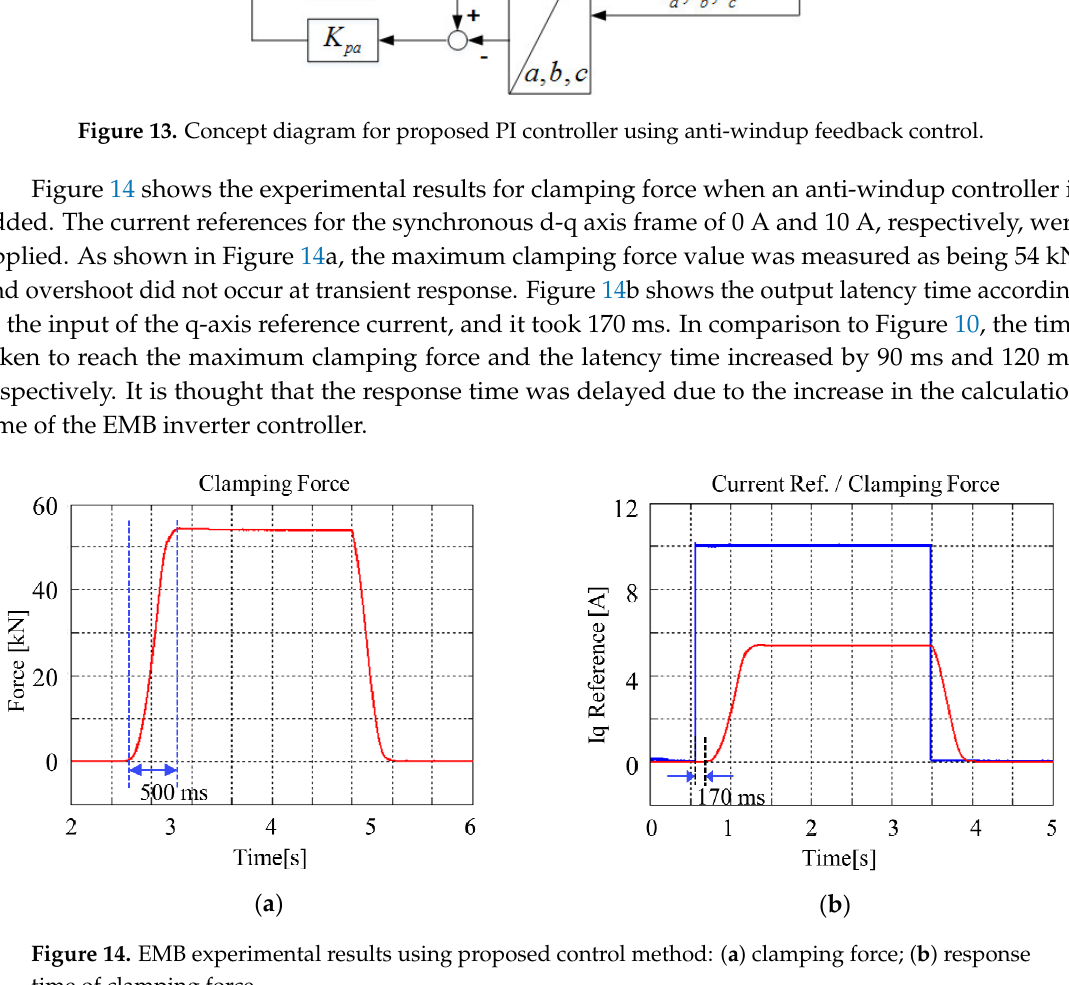
Figure 14. EMB experimental results using proposed control method: ( a ) clamping force; ( b ) response time of clamping force.